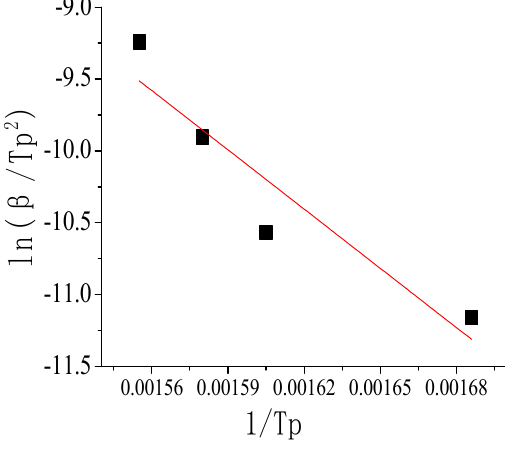
Figure 15. Relationship between ln( β / T p 2 ) and 1/ T p